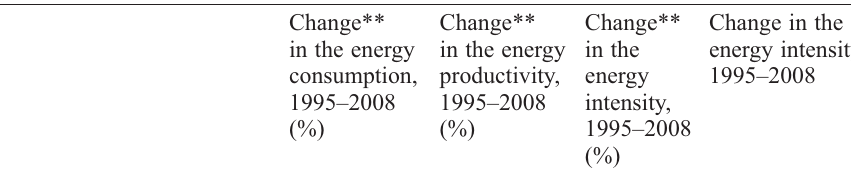
Table 5. Percentage change in the energy as factors of production